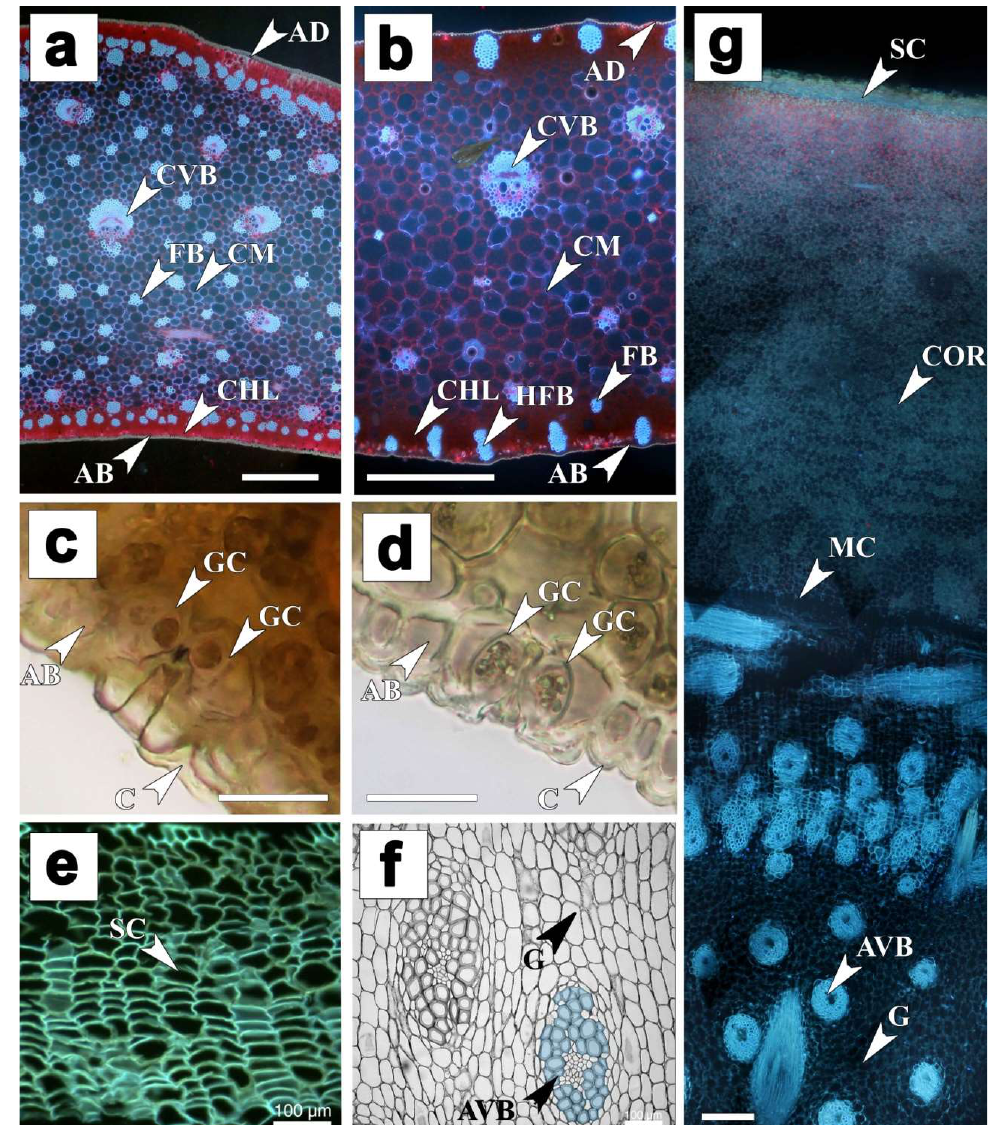
Figure 3. Anatomical details of the leaf and stem of a dragon tree. ( a ) D. cinnabari , leaf cross-section; ( b ) D. draco , leaf cross-section; ( c ) D. cinnabari , sunken stomata; ( d ) D. draco , bulging stomata; ( e ) D. draco , detail of storied cork; ( f ) D. draco, cross-section of secondary tissues with visible amphivasal vascular bundles surrounded with the ground tissue; thick-walled tracheids are marked with blue ( g ) D. cinnabari, s tem cross-section with secondary growth. Abbreviations: AB—abaxial epidermis;